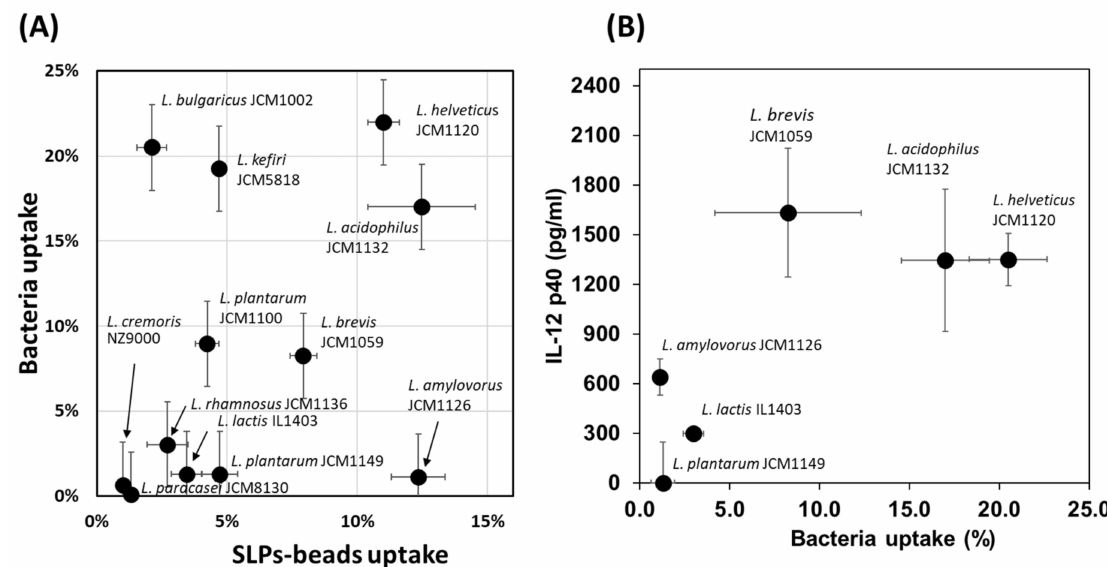
Figure 2. ( A ) Uptakes of Cy3 labelled surface layer protein A ( Cy3 SlpA) lactic acid bacteria (LAB) and Slps-coupled microbeads by THP-1 DC. ( B ) Uptake of Cy3 labelled LAB (Bacterial uptake), and IL-12 production from THP-1 cells by treatments with various LAB strains.